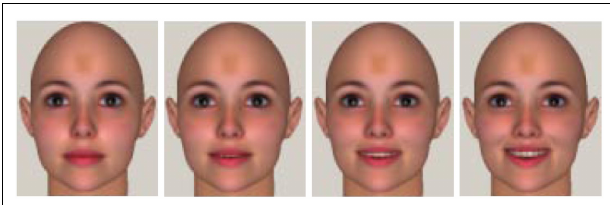
FIGURE 1 | Four female face models carrying expressions from neutral to smiling . We may take any two models as shape bases, and then the other models can be derived as weighted linear combinations of the two bases. Courtesy of Jing